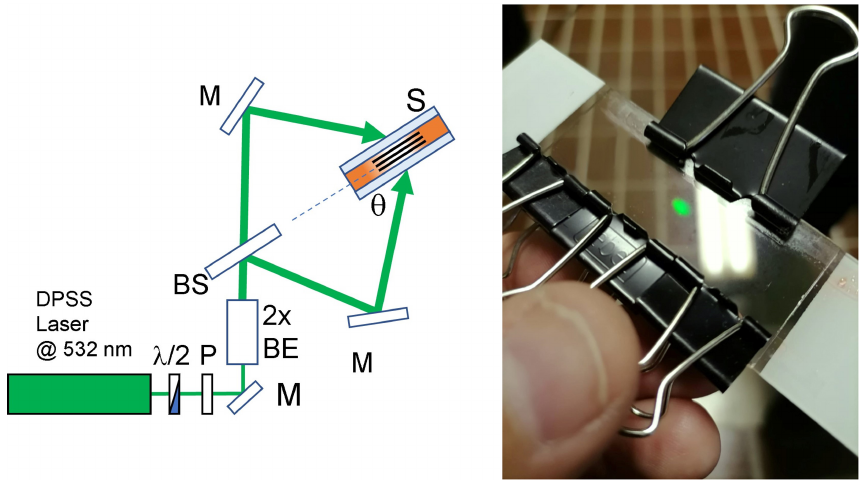
Figure 1. Schematic representation of the writing setup for the high-resolution reflection gratings. λ /2 = half wavelength plate; P = polarizer; M = mirror; 2 × BE = 2 × beam expander; BS = beam splitter; S = sample; The recorded reflection grating is shown in black. On the right a typical reflection hologram is